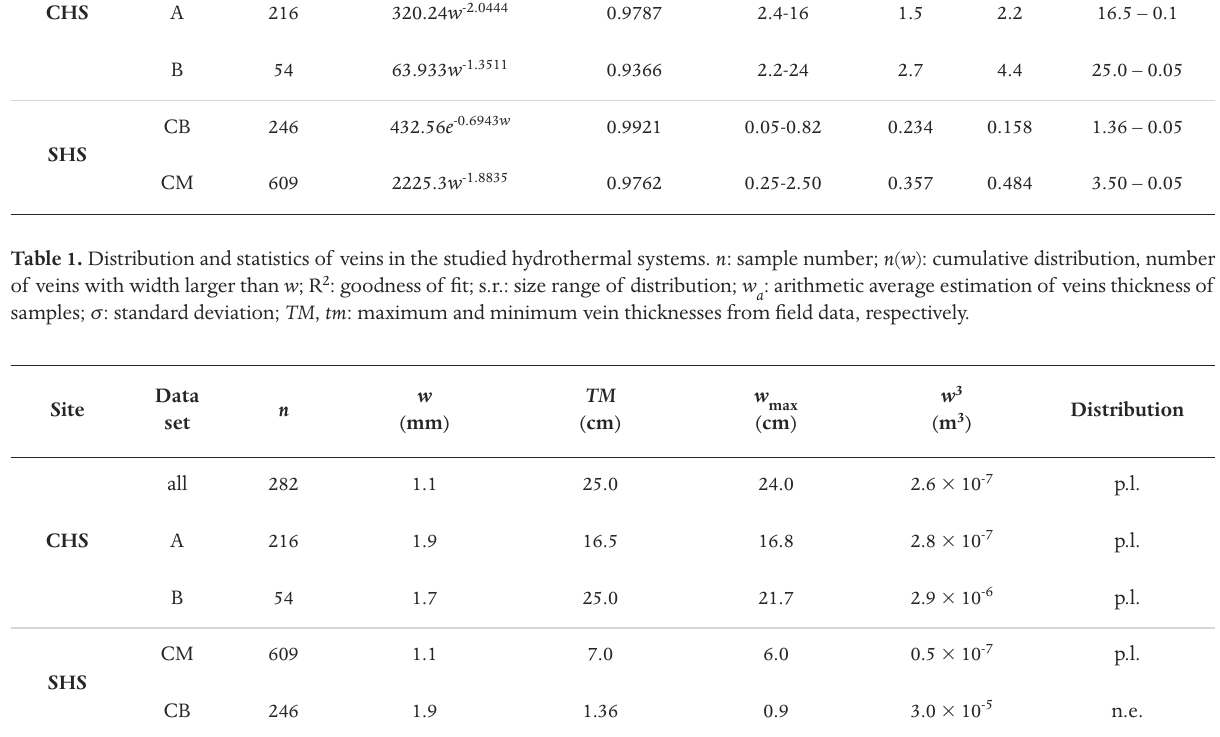
Table 2. Contribution of veins to the transmissivity (cubic law). n : number of veins; w : average thickness derived by the thickness distribu- tion; w : theoretical maximum thickness; w 3 : average cubic thickness of vein network by Equations (7); p.l.: power law distribution; n.e.: max negative exponential